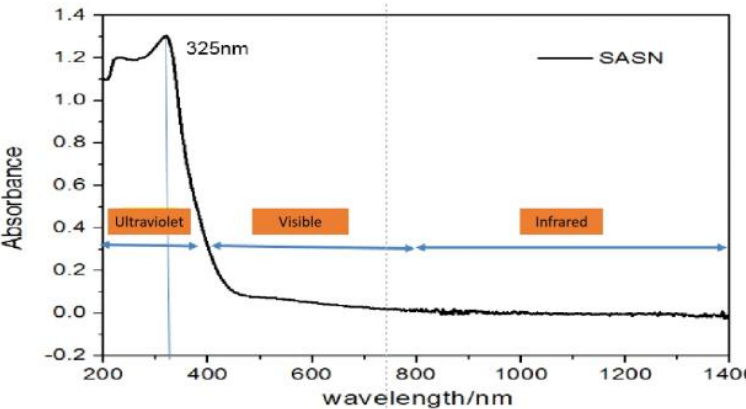
Figure 8. SASN full − band absorption spectrum curve.